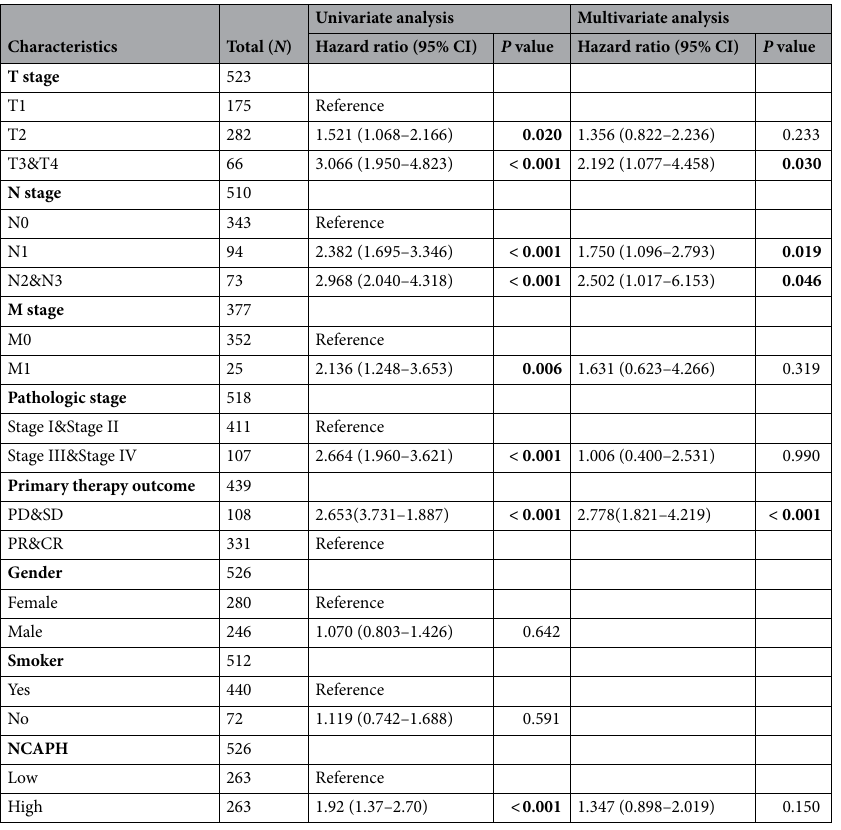
Table 3. Univariate and multivariate Cox regression analyses of NCAPH mRNA expression for overall survival (OS) in patients with LUAD from The Cancer Genome Atlas (TCGA) data set. Significant values are in bold.